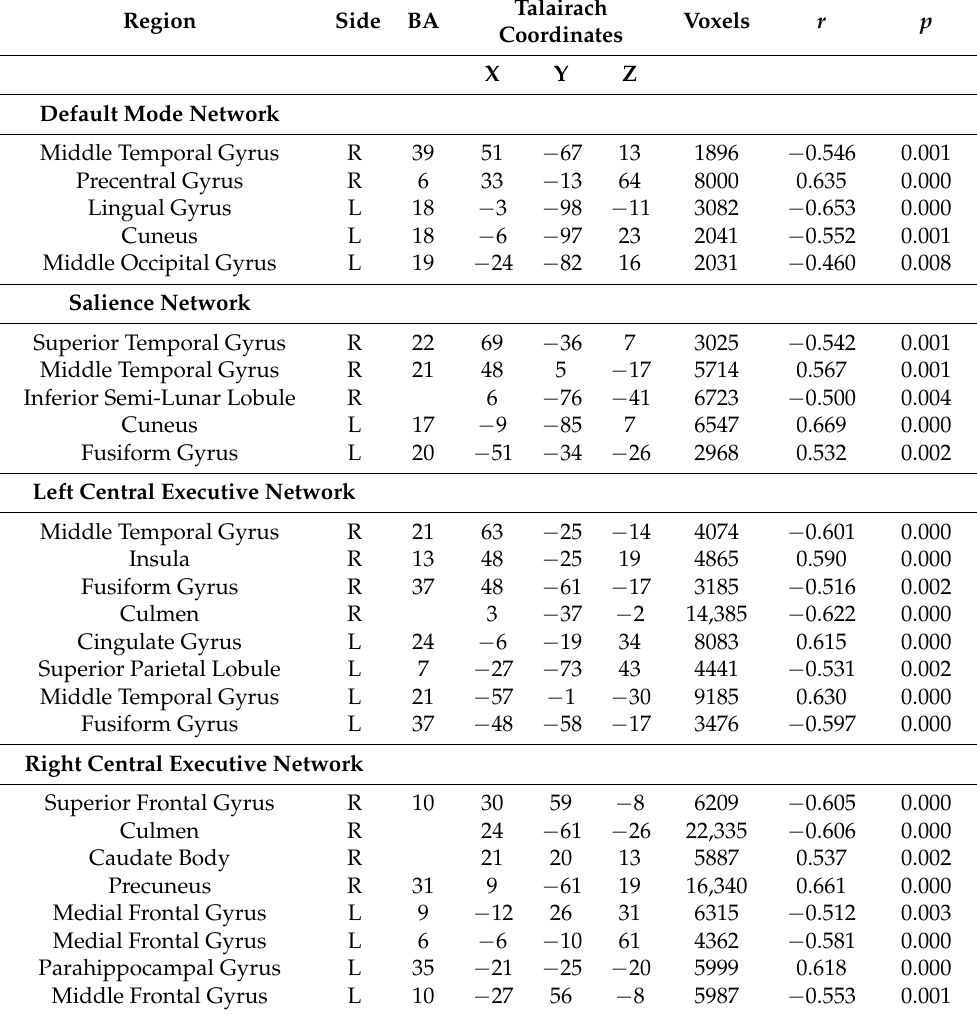
Table 1. Brain regions showing correlation of trait empathy questionnaire scores with functional connectivity values within the Default Mode Network, Salience Network, left Central Executive Network, and right Central Executive Network components. Talairach coordinates for the peak voxel in each cluster are given. Right (R) and left (L) sides of the brain are indicated; BA denotes Brodmann Area, if applicable, and the number of voxels in each of the clusters with corresponding r - and p -values.